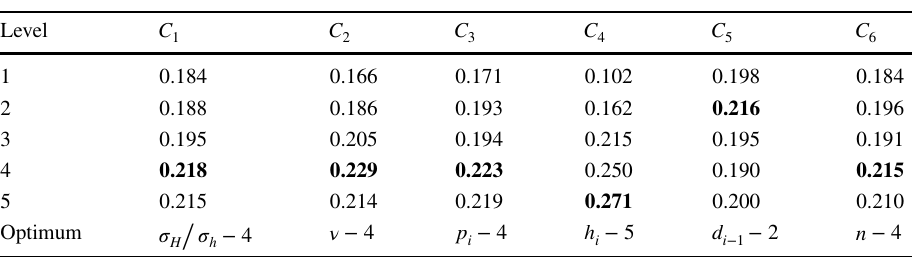
Table 6 Results of main effect analysis